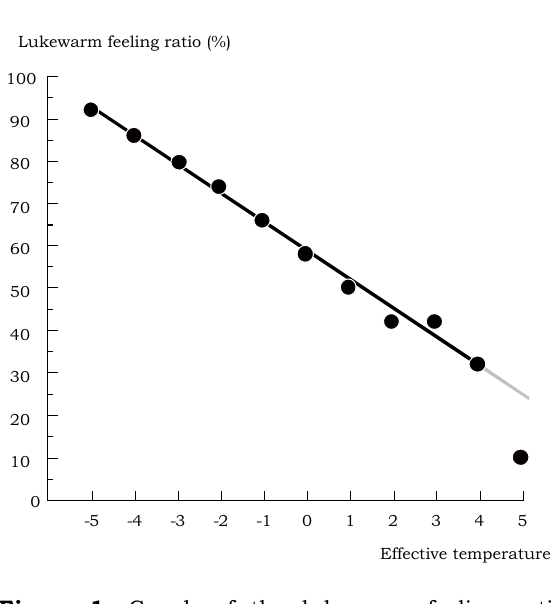
Figure 1. Graph of the lukewarm feeling ratio versus the effective temperature Table 1. Regression analysis of lukewarm feeling ratios (except for T = 5)